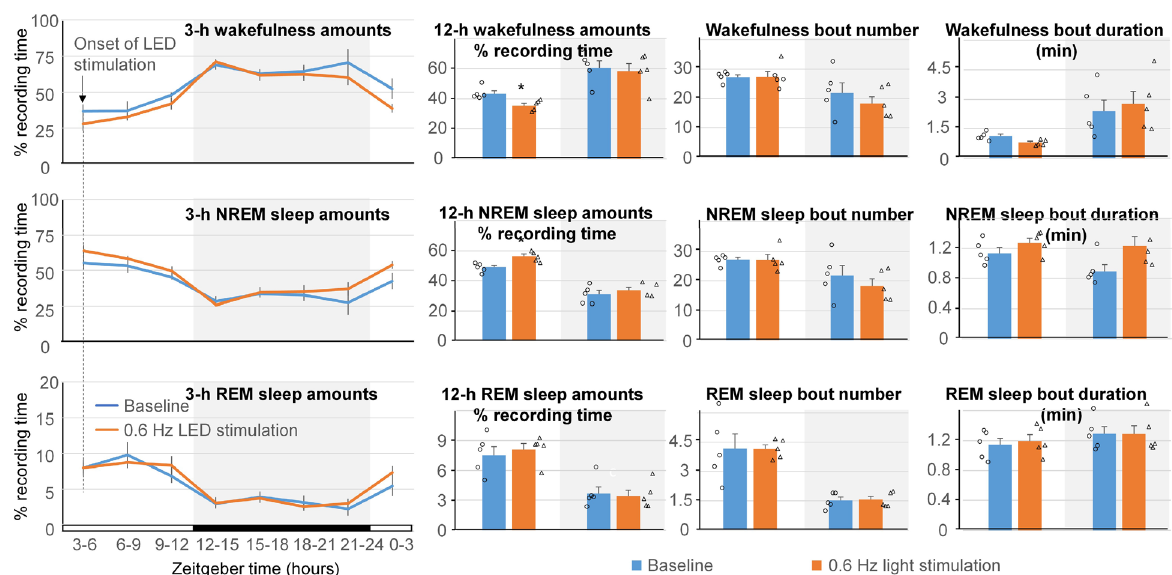
Figure 8. Effect of local stimulation of ChrimsonR containing neurons in the cerebral cortex with 10-ms 629- nm light pulses at 0.6 Hz on sleep pattern. No significant differences in the amounts of wakefulness, NREM sleep and REM sleep calculated in either 3-h or 12-h intervals between the baseline and stimulation day were found. Number and duration of sleep bouts also did not change. White background indicates light periods, and grey background indicates dark